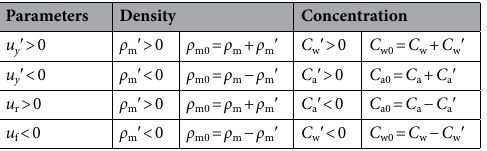
Table 1. Fluctuation properties in the air–water mixing